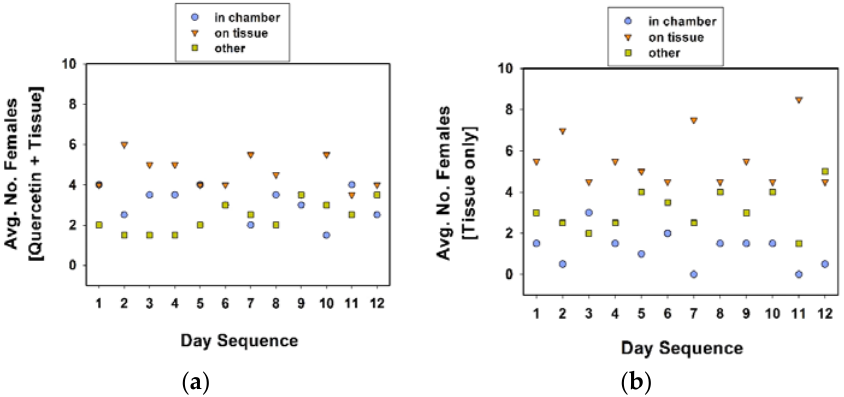
Figure 5. Average number of females in oviposition chamber, on tissue substrate, or other locales (i.e., cage walls, food dish). Treatments included quercetin powder in the chamber and tissue substrate outside ( a ), and tissue substrate outside the chamber ( b ). A total of 10 females (in each cage) were observed twice each day at approximately 09:00 and 16:00 h, over 12 days. Females were included in experiment 4. Table 5. Two ‐ way analysis of variance (ANOVA) statistics of the interaction between treatment and location of C . maculata females in communal 1 cages.